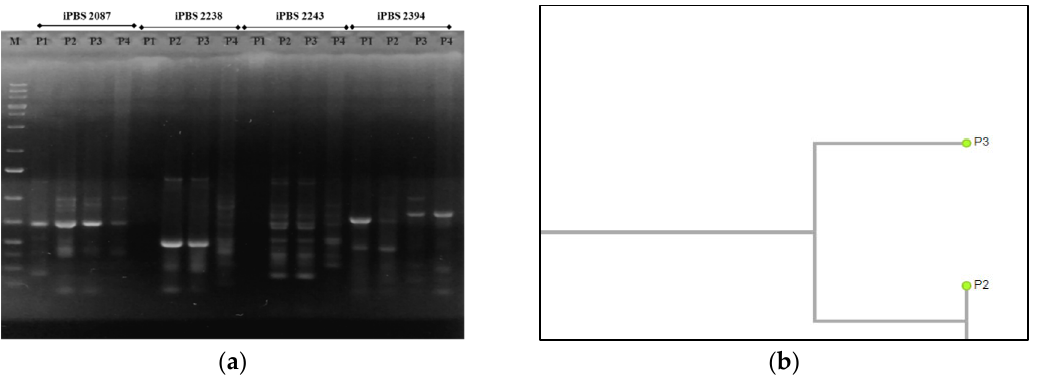
Figure 8. Results of the PCR analysis of Pinus nigra through the iPBS markers: ( a ) PCR pro fi les of Pinus nigra genotypes with four iPBS primers (2087, 2238, 2243, and 2394); ( b ) dendrogram of the cluster analysis (UPGMA) on the basis of ampli fi ed polymorphic bands of experimental saplings in the PCR analysis, CP = 0.970. Legend : M—molecular marker; P1, P2, P3, P4— Pinus nigra genotypes from four experimental plots.